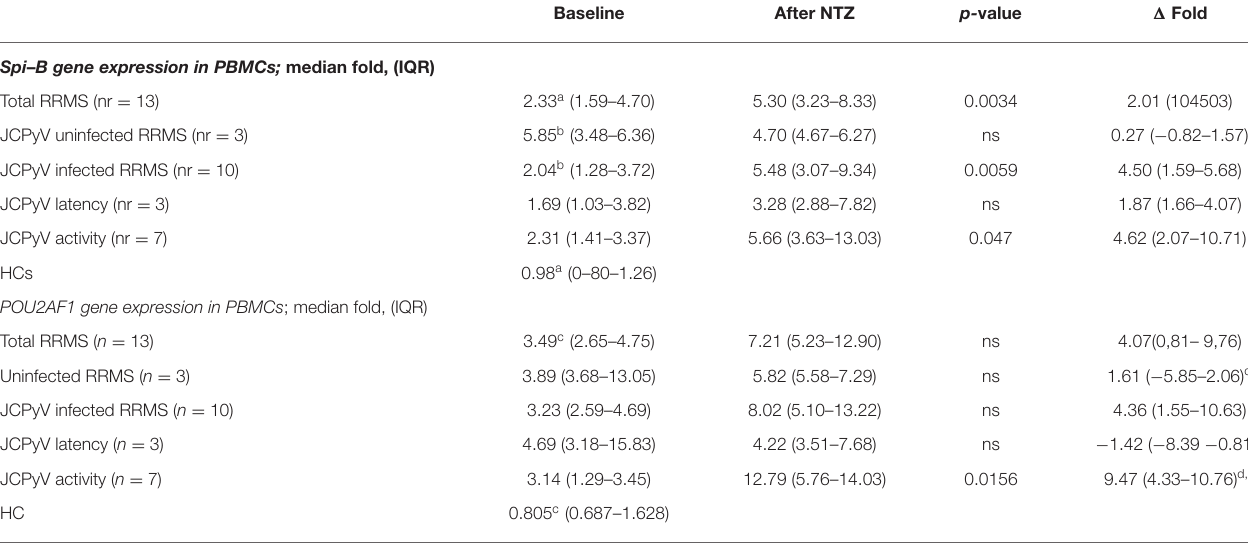
TABLE 3 | The gene expression of Spi-B and POU2AF1 in PBMCs form natalizumab (NTZ) treated patients with RRMS. Baseline After NTZ p- value 1